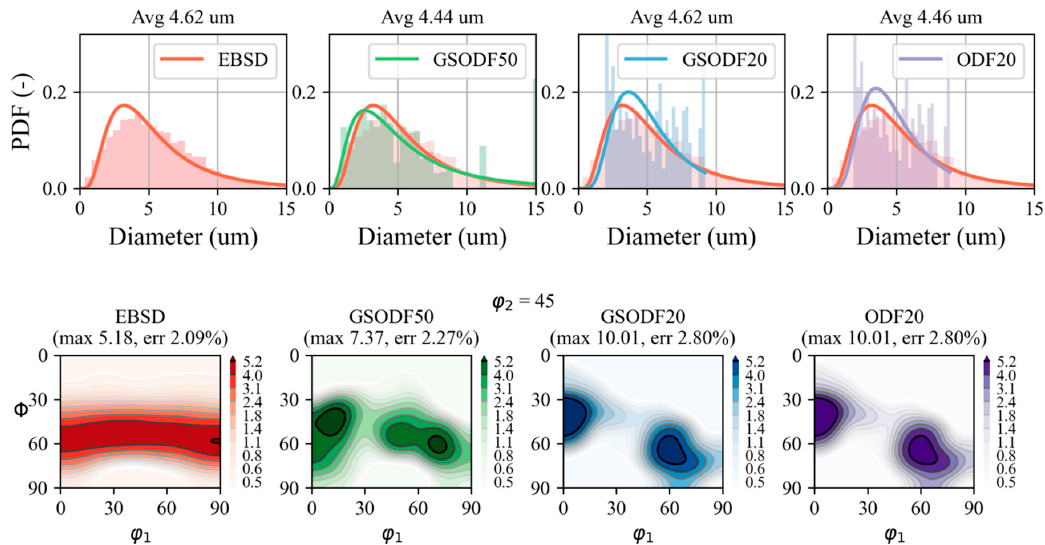
Figure 17. Obtained grain size distributions and crystallographic textures ( ϕ 2 = 45 ◦ sections) in EBSD experiments and DAMASK simulations using the model parameters fitted with VPSC. For each grain size distribution, the average grain size is shown on top. On top of the textures, it is show which is the maximum value and the error with respect to the ODF calculated from the EBSD data, or between the calculated ODF and the raw data (see caption of Figure 6).